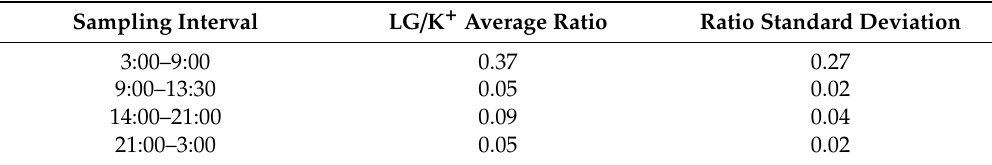
Table 4. Mean value and standard deviation of the LG / K + ratio in each sampling interval. Sampling